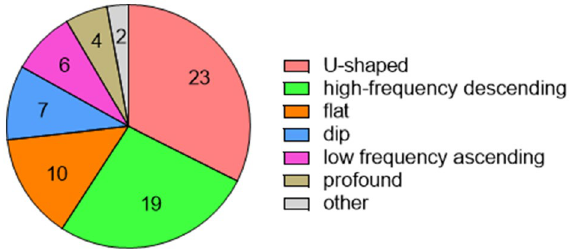
Figure 3. Distribution of patients’ audiogram forms obtained during the first episode of sudden sensorineural hearing loss. “Other” means that the audiogram characteristics did not adequately fit the descriptions of any of the six defined forms (see Methods). This pie chart was created using GraphPad Prism 9.0.0 for Windows, GraphPad Software, San Diego, California USA, www. graph pad. com.